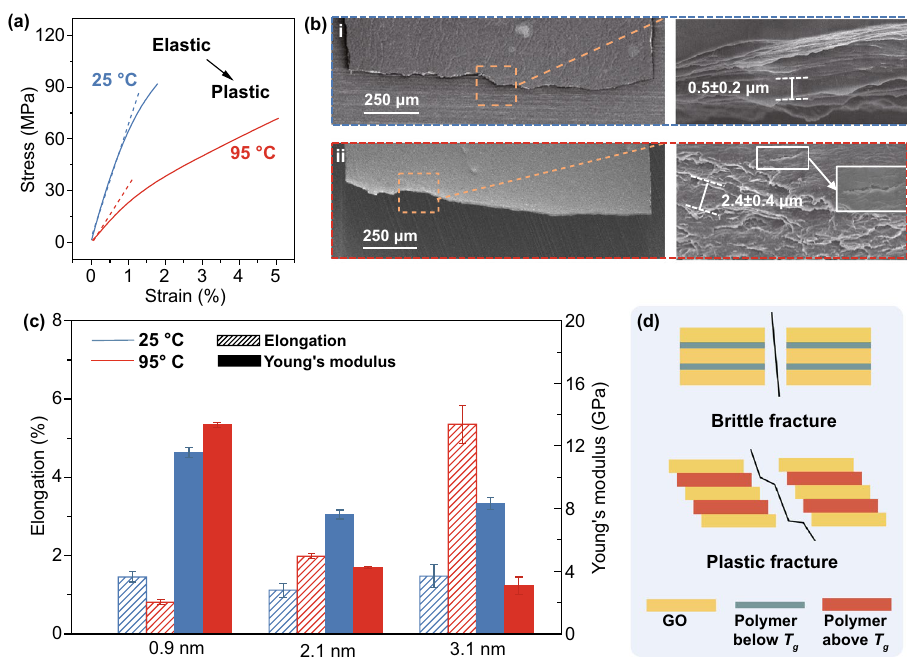
Fig. 3 a Typical stress–strain curves of Pi-GOS ( d = 3.1 nm) at 25 °C (blue) and 95 °C (red). b SEM images of transverse cross section mor- phology of Pi-GOS ( d = 3.1 nm) after tensile breaking at 25 °C (top) and 95 °C (bottom). c Young’s modulus and elongation of Pi-GOS with different d -spacing at 25 °C (blue) and 95 °C (red). d Schematics of brittle tensile fracture of Pi-GOS below T g and plastic tensile fracture above T